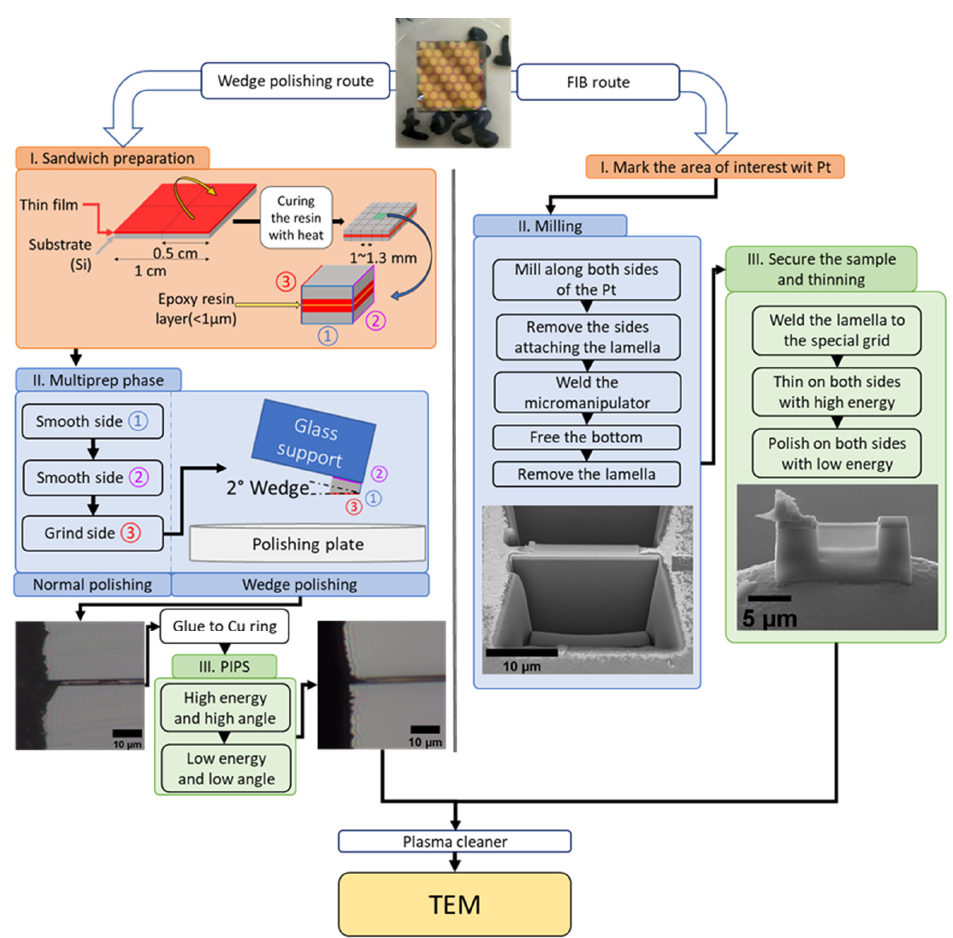
Figure 1. Flowchart for TEM sample preparation via wedge polishing ( left side ) and FIB lift-out ( right side ).